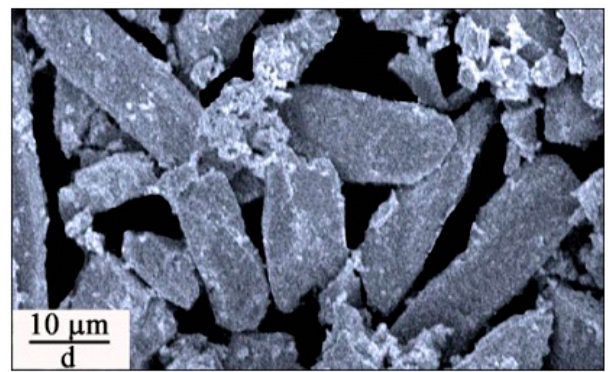
Figure 5. SEM micrographs of Eu-doped ZnWO 4 precursors subjected to annealing at different temperatures: ( a ) 400 °C; ( b ) 600 °C; ( c ) 800 °C and ( d ) 1000 °C.